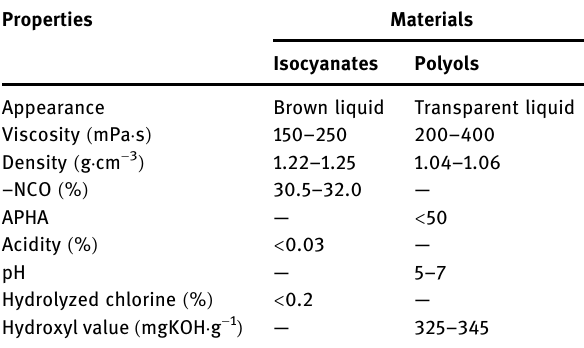
Table 1: The material properties of isocyanates and polyols Properties